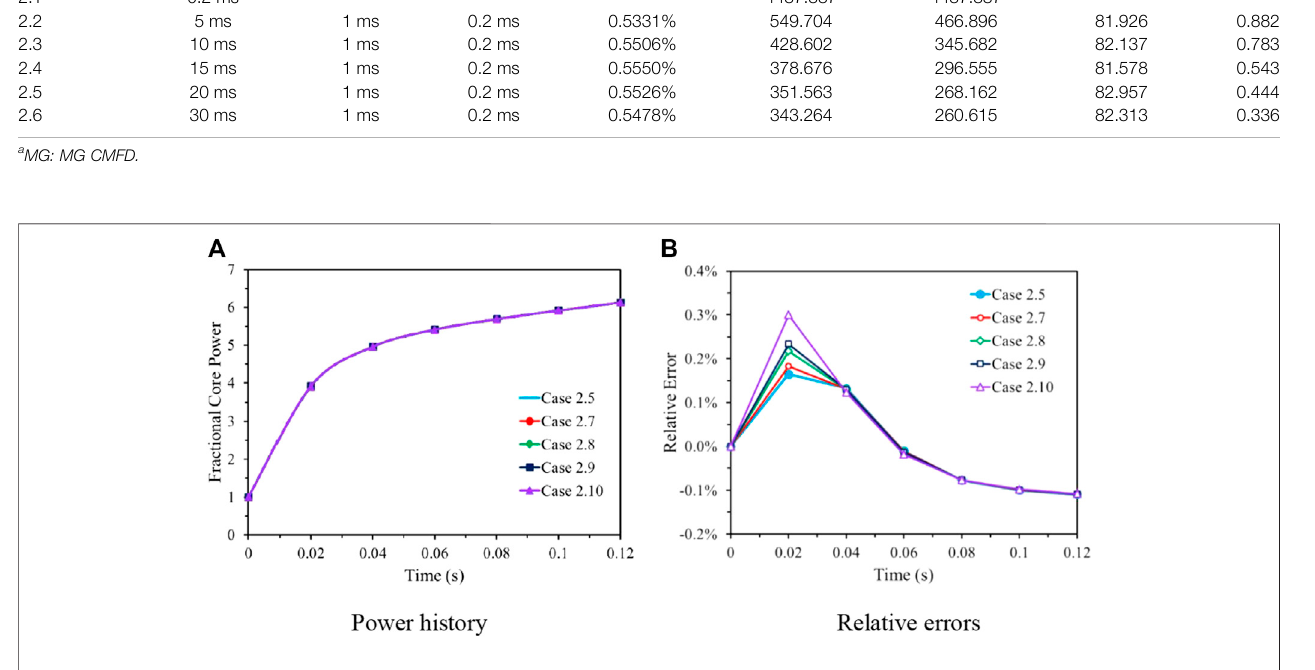
FIGURE 9 | The AML-PCQM cases ’ results in Problem 2. (A) Power history (B) Relative errors.